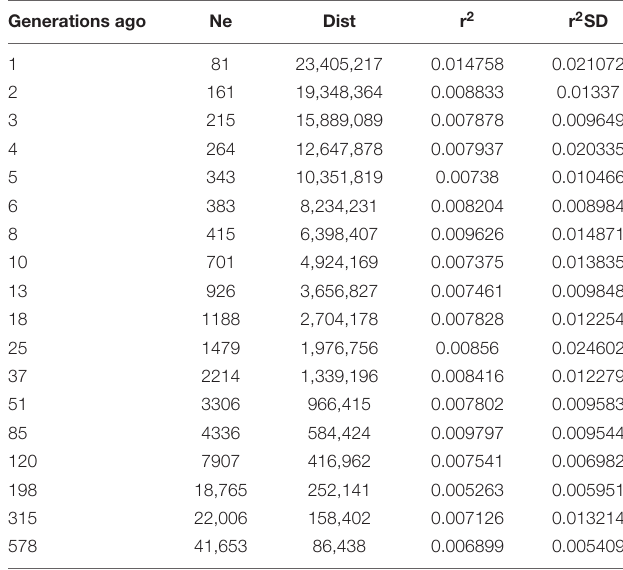
TABLE 4 | Effective population size (Ne) for C. carpio in the southern basin of the Caspian Sea (dist: average distance between loci; r 2 : average LD; r 2 SD: LD standard